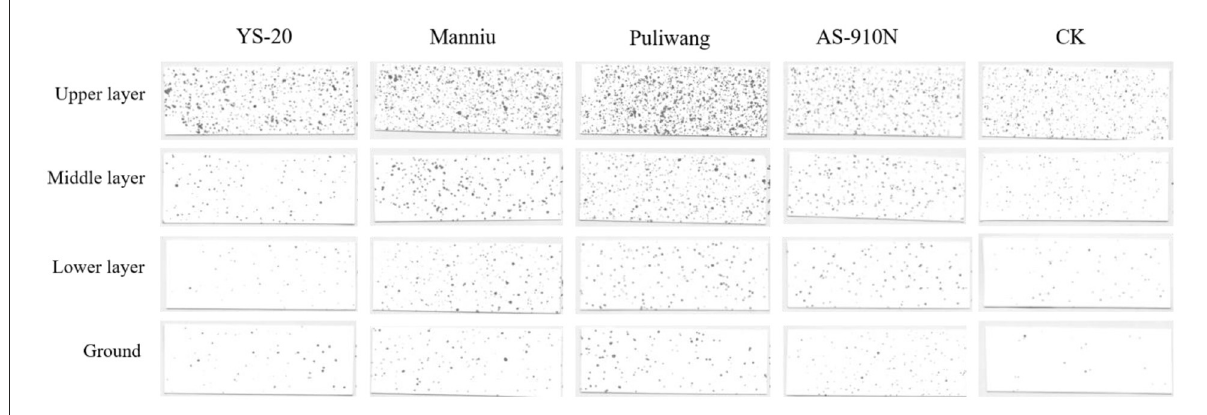
FIGURE7 Effect of aerial spray with adjuvants on the droplet coverage sprayed by UAV (gray-scale photos of WSP).